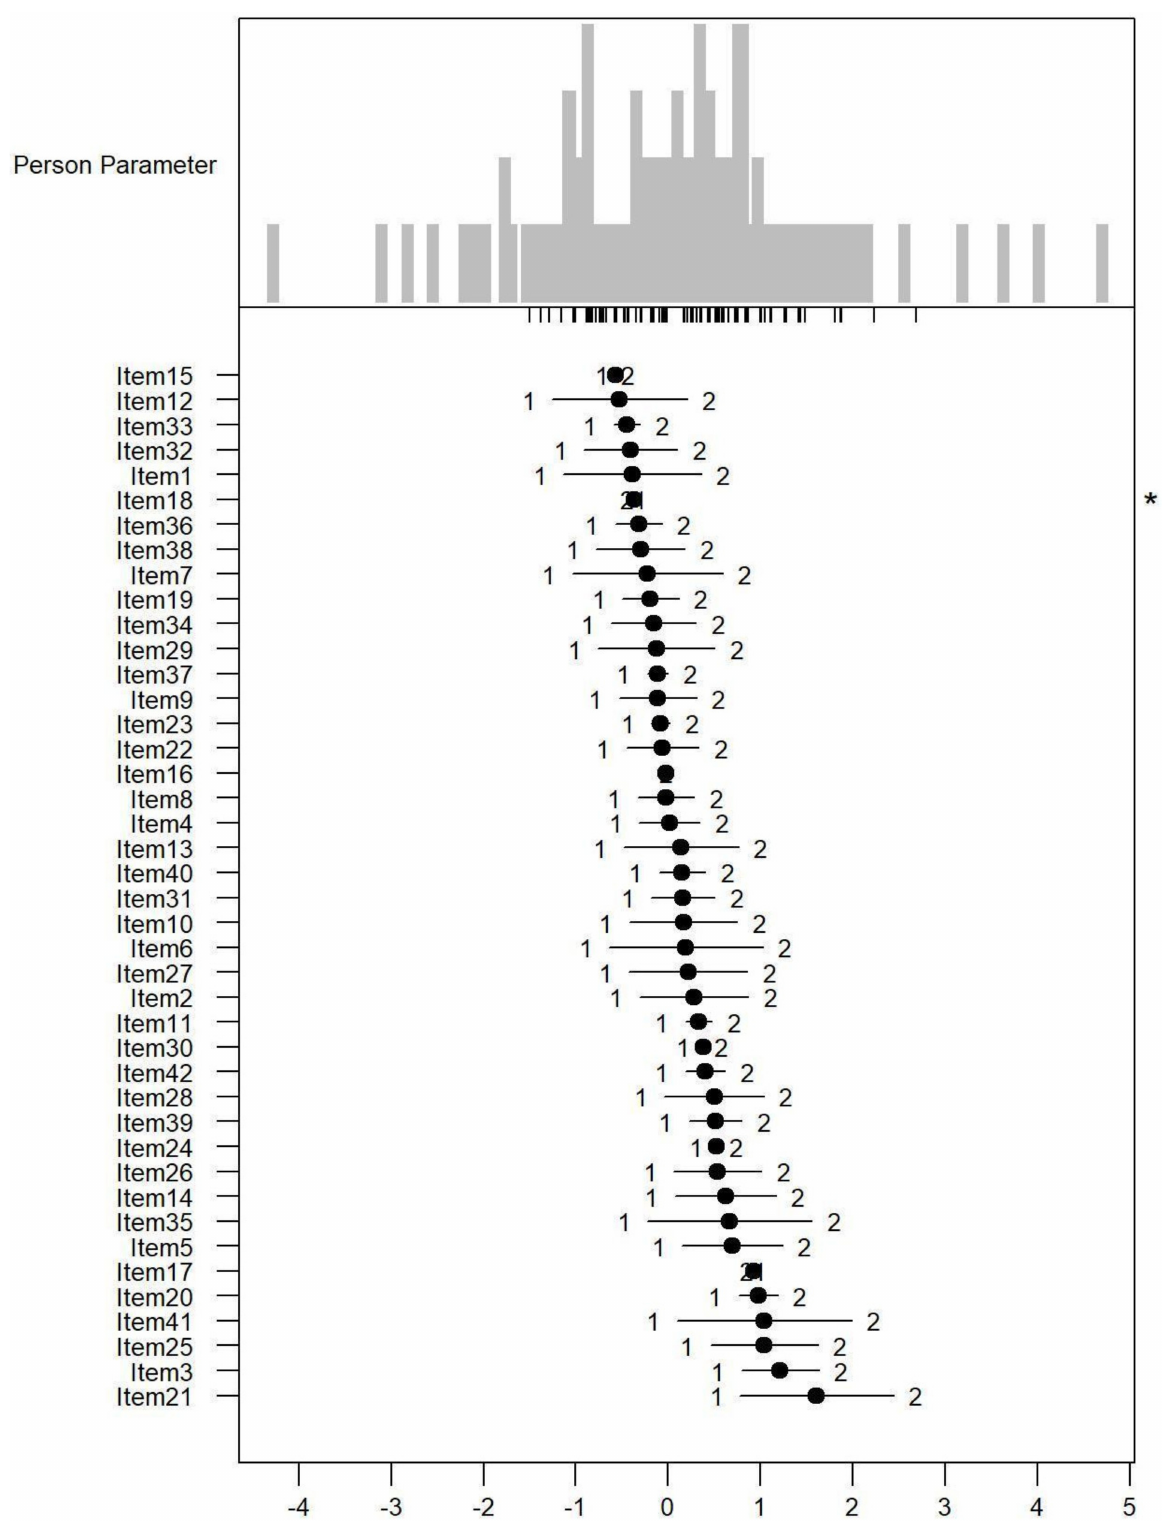
Figure 3. Person-item map for the person parameter and item parameter distribution of the Paradise and Eden items combined having three response categories (1 = none, 2 = mild to moderate, and 3 = severe to extreme PSDs). * Disordered thresholds are flagged by means of a ‘*’ in the margin of the